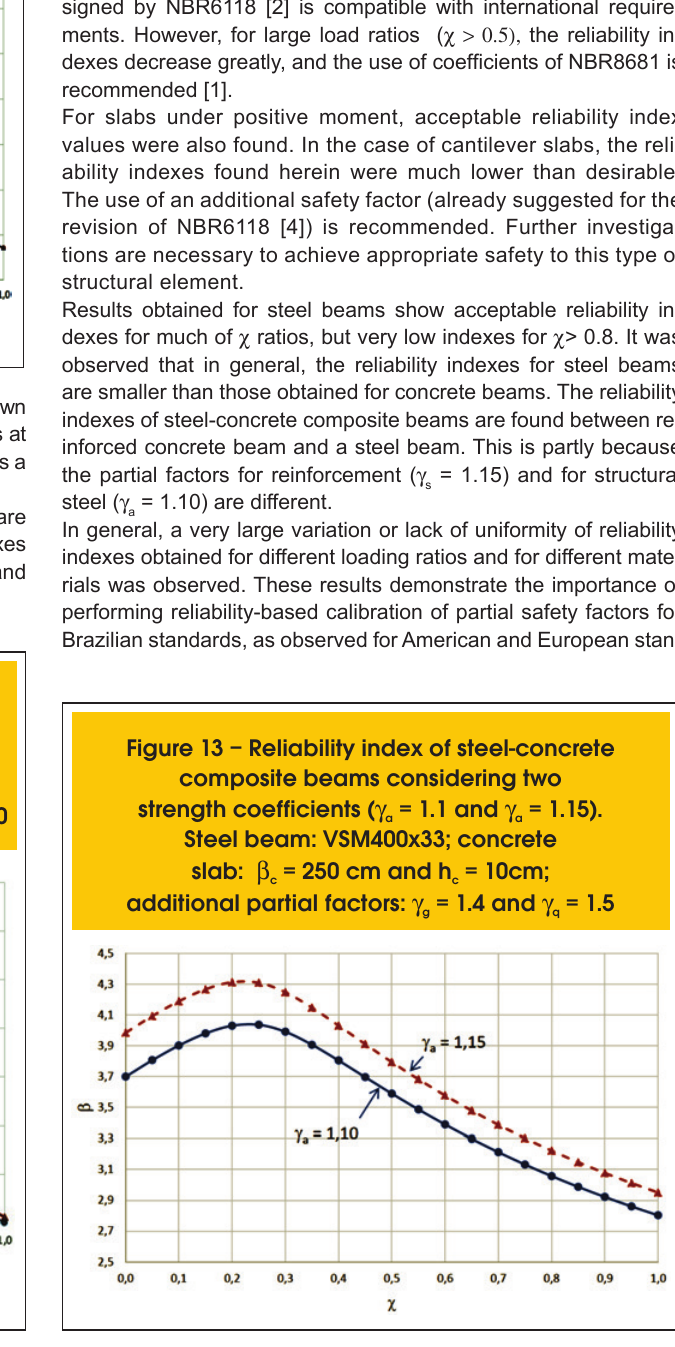
Figure 11 – Reliability index of a steel beam with compact section and laterally restrained, designed with partial factors of NBR8800 [3] for types I and II buildings